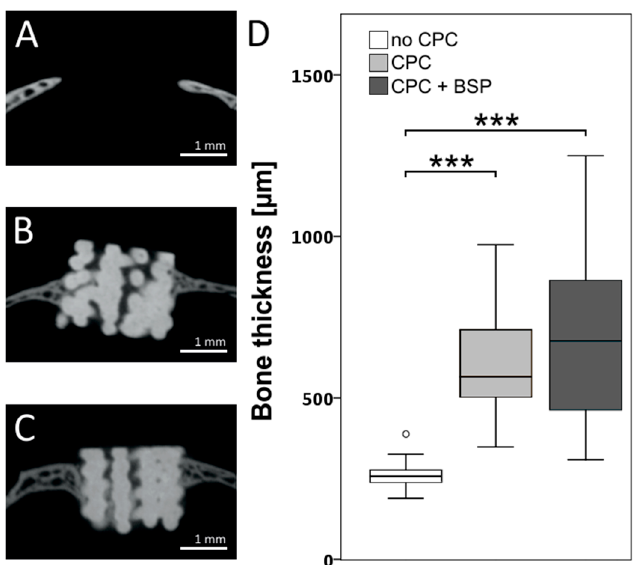
Figure 4. Coronal µCT section of the calvarial defect with inserted scaffold. ( A ) Negative control (no CPC); ( B ) CPC; ( C ): CPC + BSP; ( D ) Boxplots represent bone thickness in µm at the margin of the defect. Statistically significant differences (p < 0.001) to the control group are labeled by three asterisks.